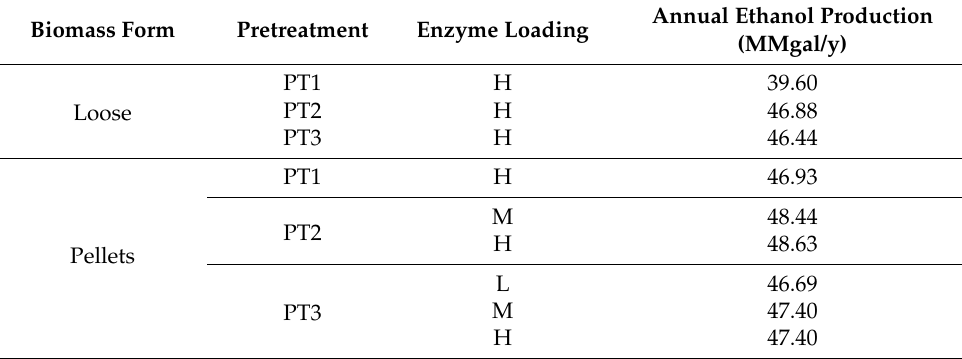
Table 5. Annual ethanol production for loose and pelleted biomass under different pretreatment conditions and enzyme loadings with 2000 MT/d